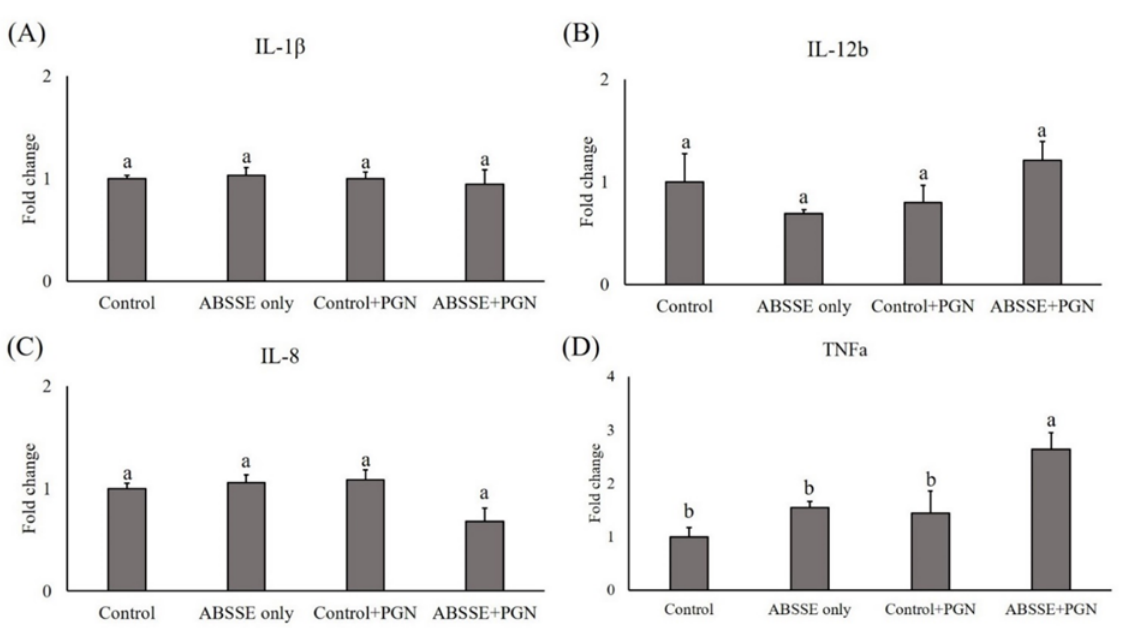
Figure 5. Gene expression analysis of Agaricus blazei spent substrate extract (ABSSE)-primed THK cells after stimulation with peptidoglycan (PGN). The THK cell line was primed with 0 (control) or 10 μg/mL of Agaricus blazei spent substrate extract (group ABSSE only) for 24 h and subjected to gene expression analysis. Additionally, THK cells were pre-treated with L-15 medium or medium containing ABSSE and then stimulated with 50 μg/mL PGN for 24 h. The former group was named “control + PGN” and the later “ABSSE + PGN”. Transcript levels of ( A ) IL- 1β , ( B ) IL-12b , ( C ) IL-8 , and ( D ) TNF- α were analyzed by quantitative real-time PCR. The expression values are shown as means + standard errors of the mean fold change relative to the control group. Significant differences ( p < 0.05, one-way ANOVA, and Tukey’s post hoc test) from the control group are indicated by different letters.